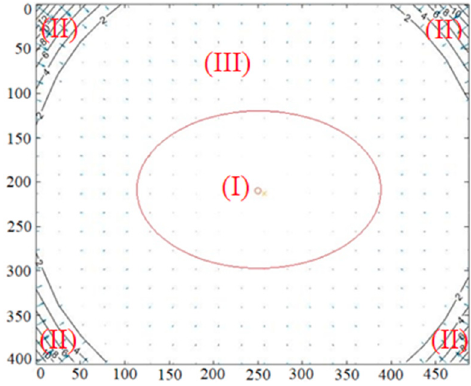
Figure 5. Complete distortion effect of the infrared camera.